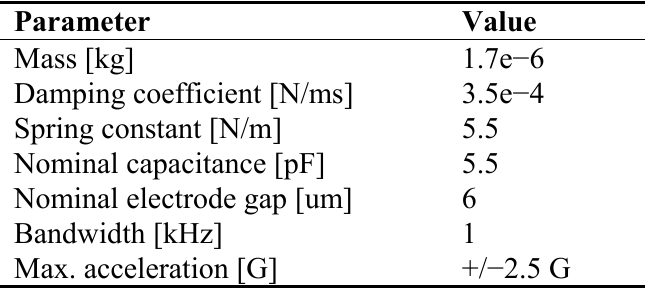
Table 1. MEMS Accelerometer Parameters.